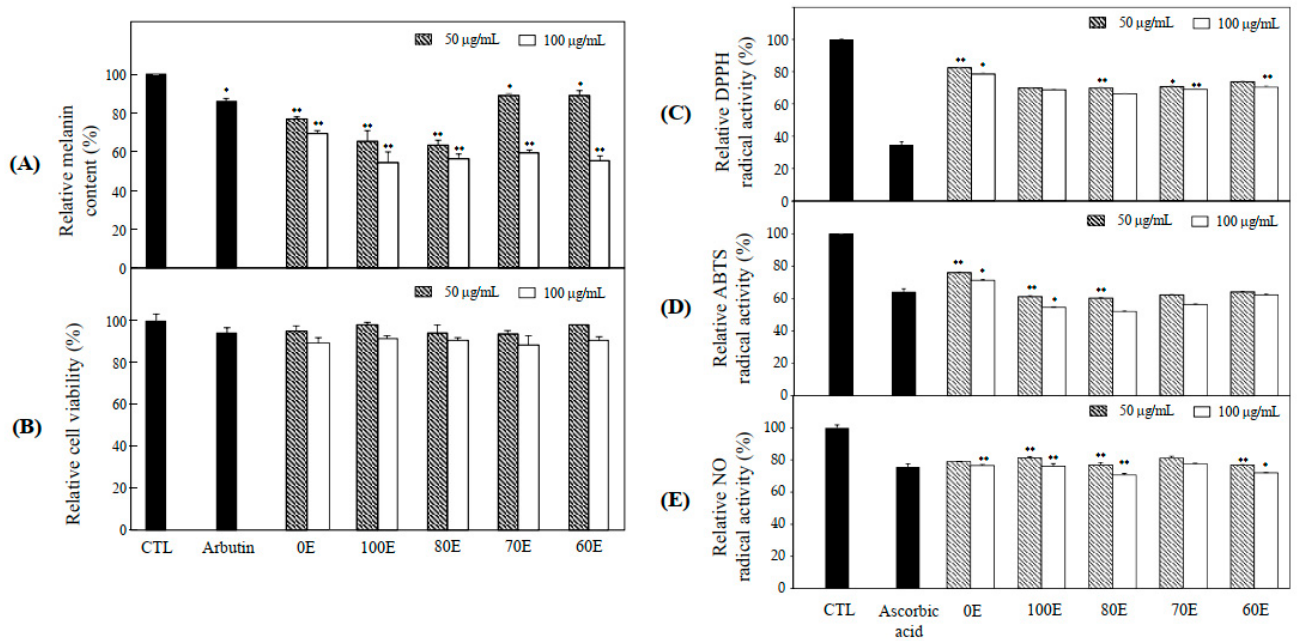
Figure 1. Anti-melanogenesis and anti-oxidant effects of S. glabrescens extracts. ( A ) Melanin content, ( B ) cytotoxicity in B16F10 cells, ( C ) DPPH and ( D ) ABTS, and ( E ) NO radical scavenging activities. The data are represented as the mean ± SD (n = 3) of three individual experiments. * p < 0.05, and ** p < 0.01 compared with control.